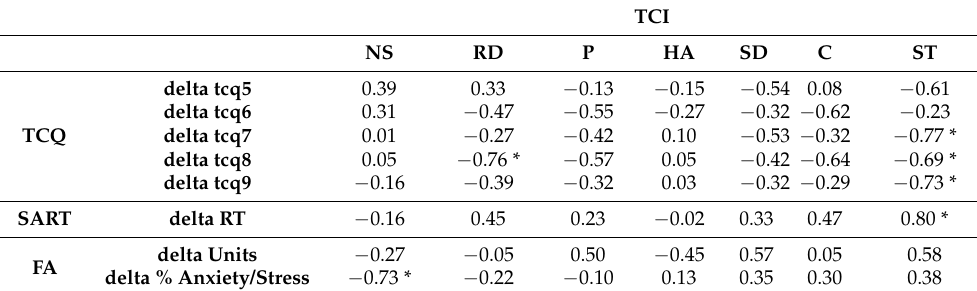
Abbreviations as in Table 1. Asterisks indicate p <